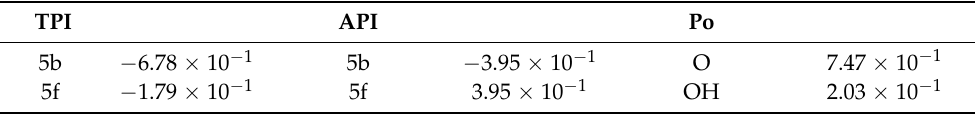
Table 6. The largest TPI, API and Po for the mode that points to O at P 2 ; Only contributions larger than 5% are